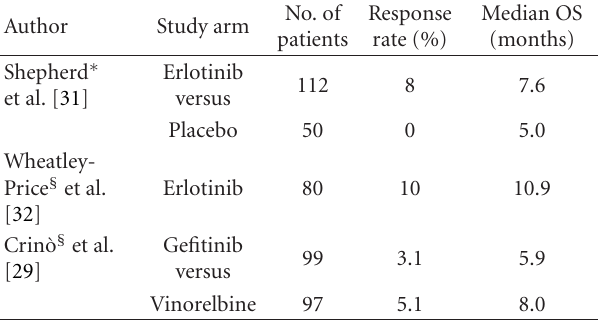
Table 1: Main studies on EGFR TKIs for elderly ( ≥ 70 years) patients with advanced